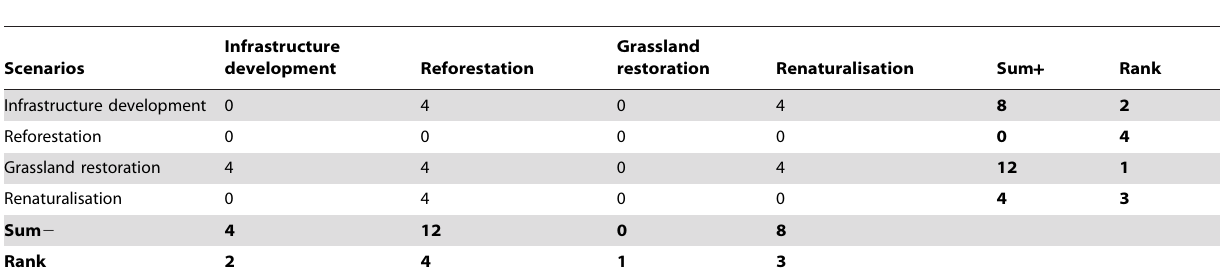
Table 3. Total preference matrix summarising results of carrying capacity sensitivity analysis.